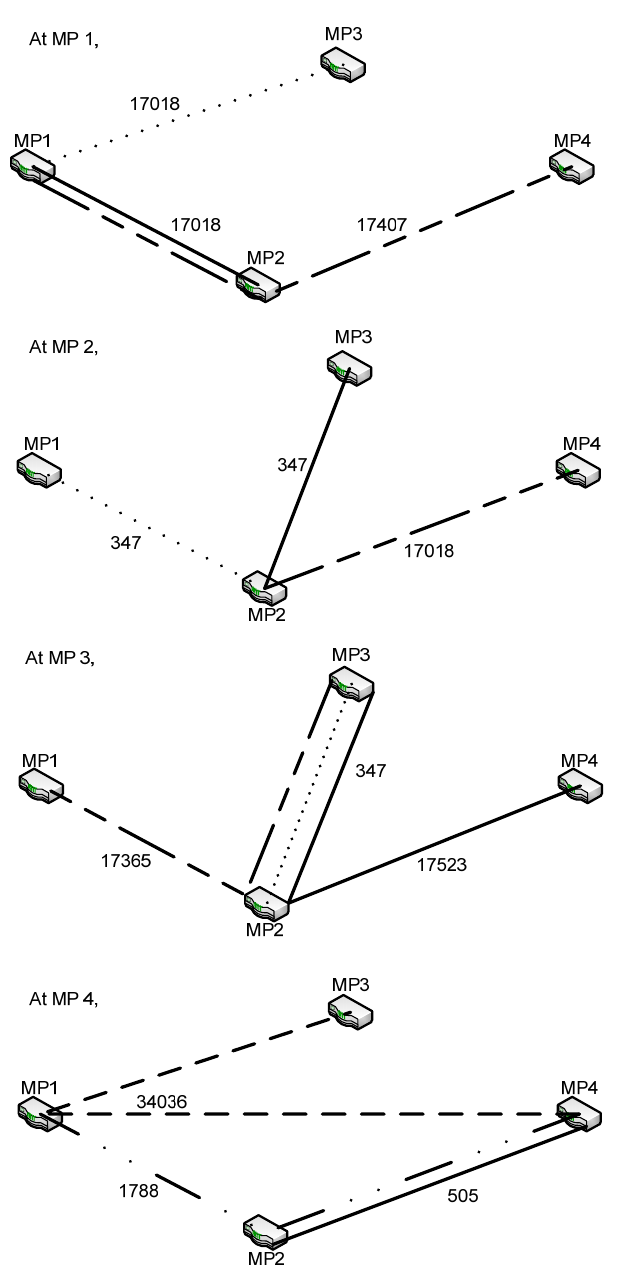
Figure 12. The path selected at each node (Trial